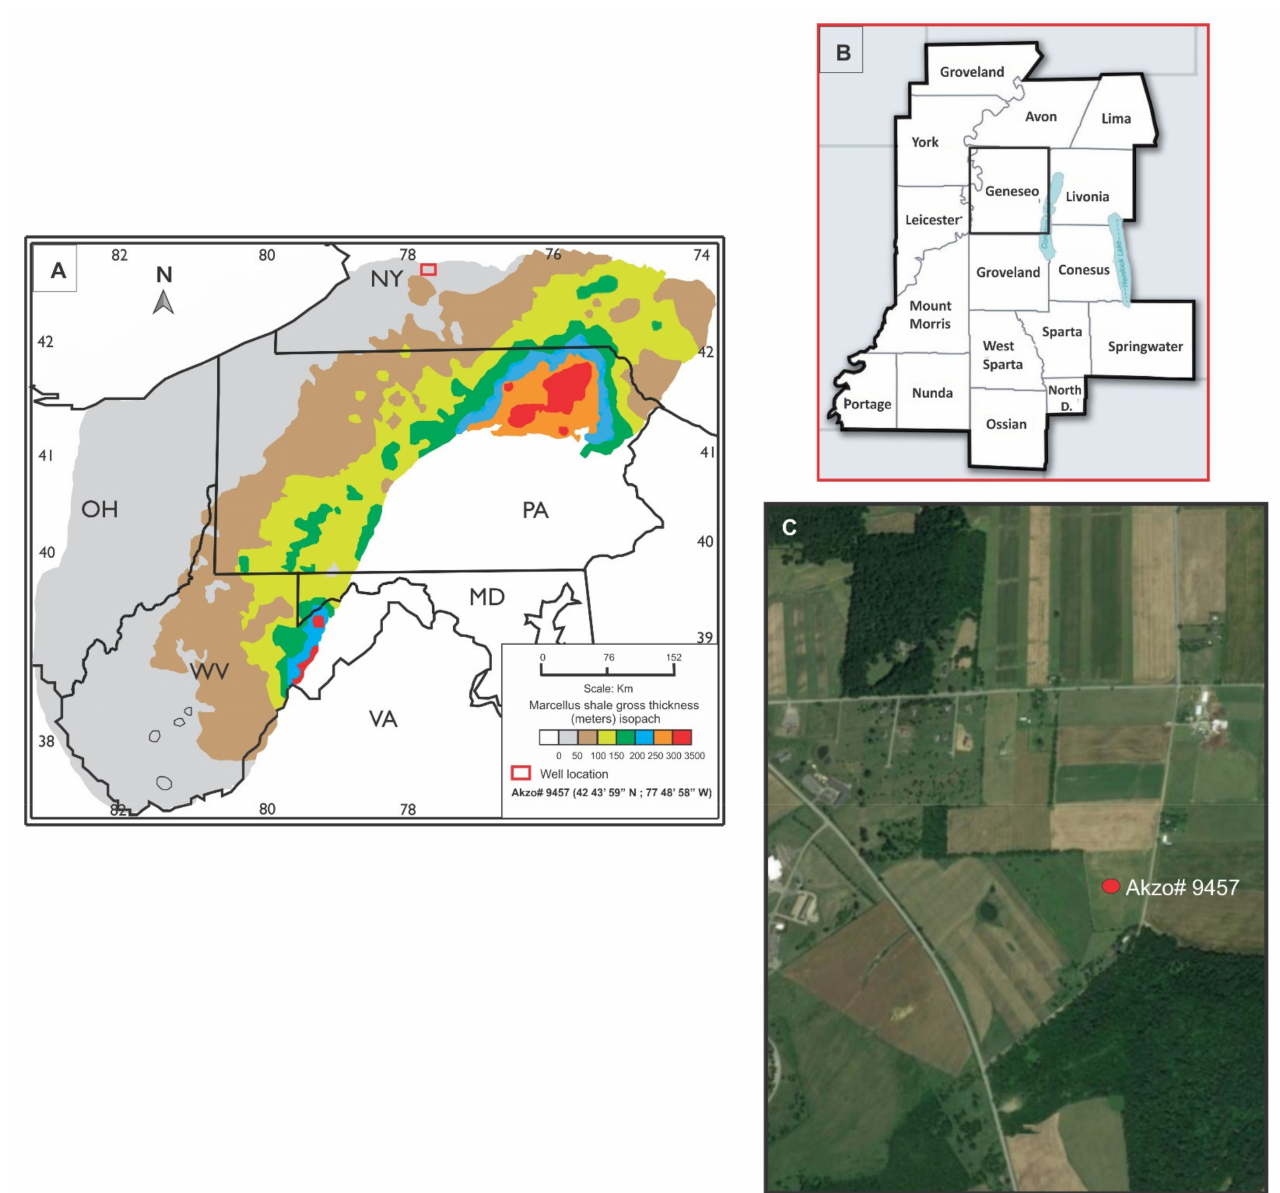
Figure 1. ( A ) Map of the Appalachian Basin showing the gross thickness (in meters) of the Marcellus subgroup strata in the subsurface. The rectangle in red shows the location of the examined well in New York State, USA [33]. ( B ) Livingston County map in New York showing the town of Groveland where the studied well was drilled. ( C ) Map showing detailed location of the Akzo# 9457 in the town of